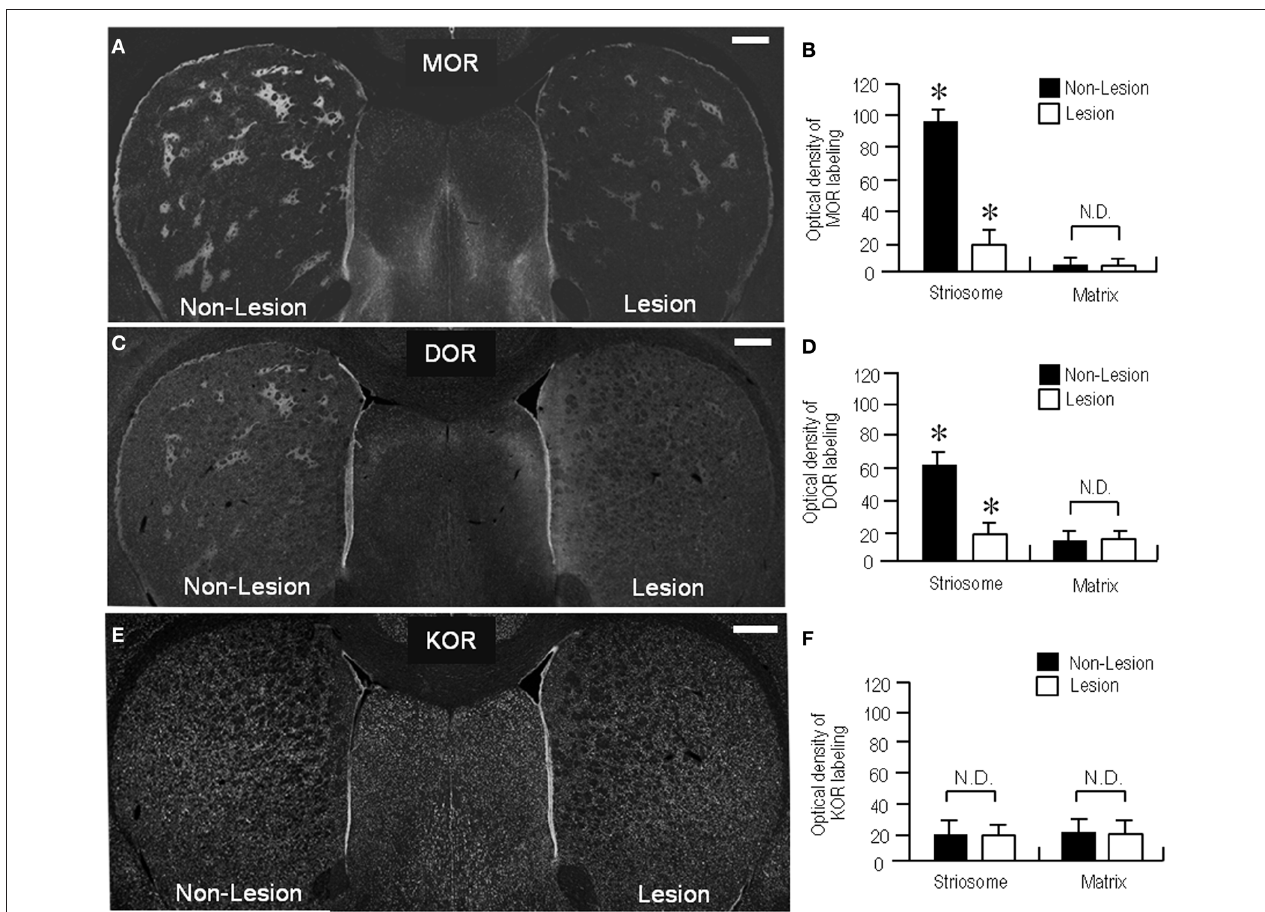
FIGURE 6 | Loss of striosomal labeling for MOR and DOR in rats with unilateral 6-OHDA lesions of nigrostriatalpathways. (A) A representative image of the forebrain sections stained for MOR. (B) Optical density measurements of MOR labeling in the striosomes and matrix compartment in thedorsolateral portions ofthenon-lesioned (Non-Lesion) andlesioned (Lesion) striatum. Data are mean ± S.E.M. (bars) values ( n = 25). ∗ P < 0 . 005 (Mann–Whitney U -test), Non-Lesion vs. Lesion. N.D. indicates no statistically significant difference ( P > 0 . 05, Mann–Whitney U -test) between Non-Lesion and Lesion. (C) A representative image of the forebrain sections stained for DOR. (D) Optical density measurements ofDORlabeling inthe striosomes and matrix compartment in the dorsal striatum of the non-lesioned (Non-Lesion)